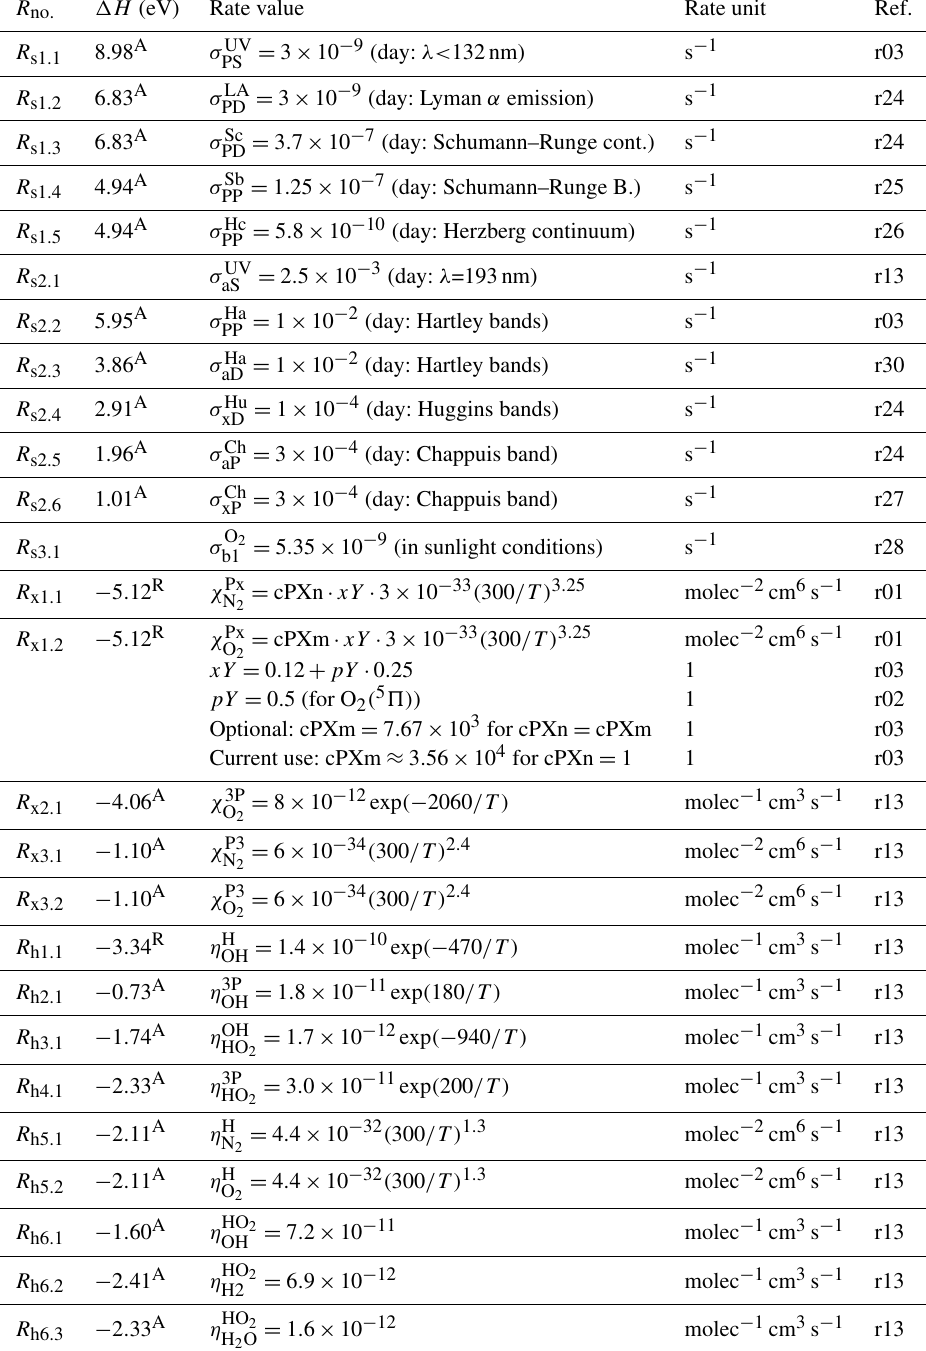
Table 11. Rate values of the processes listed in Table 7. References: r24 – Nicolet (1971), r25 – Nicolet et al. (1989), r26 – Nicolet and Kennes (1988), r27 – Nicolet (1989), r28 – Mlynczak et al. (1993), r29 – Atkinson et al. (1997), r30 – Khomich et al. (2008). The labels r01, r02 and r03 were used in Table 8, and the label r13 was used in Table 9. The exothermic reaction energy content was determined for each reaction at standard temperature and pressure; see the (cid:49)H column for the enthalpy change. (cid:49)H values were read out (unit: eV) from Roble (2013) (marked by character R) and (units: kJmol − 1 ) from Atkinson et al. (1997) (marked by character A). Additionally, (cid:49)H values were evaluated (marked by character